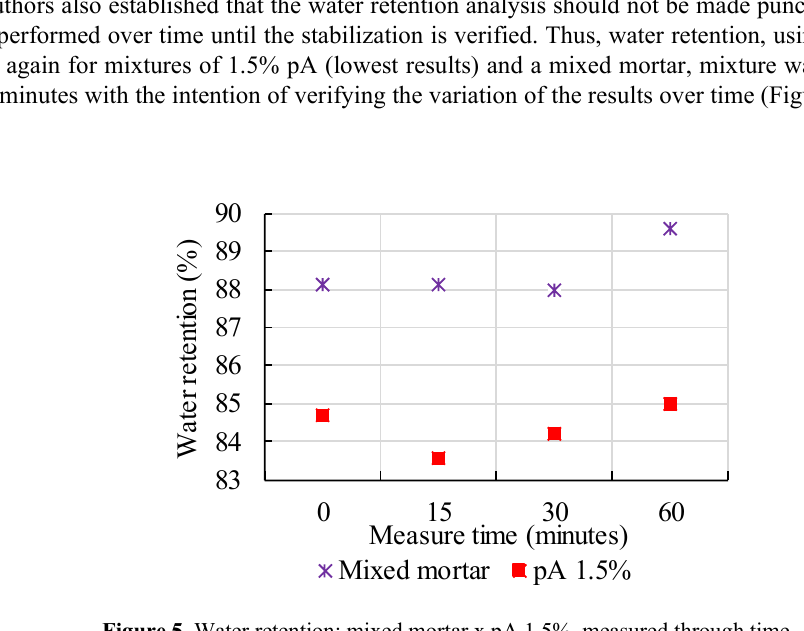
Figure 5. Water retention: mixed mortar x pA 1.5%, measured through